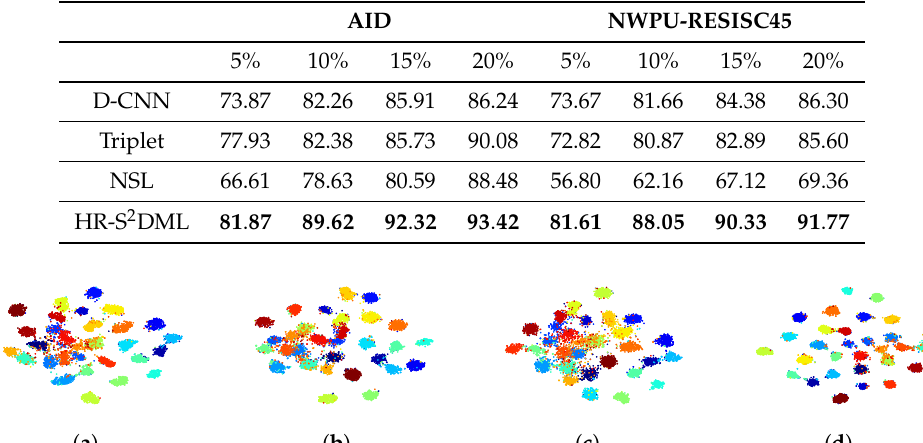
Table 3. ACC assessment (%) for the test set embeddings of the different methods, when the percentages of labeled images are 5%, 10%, 15%, and 20%, respectively.